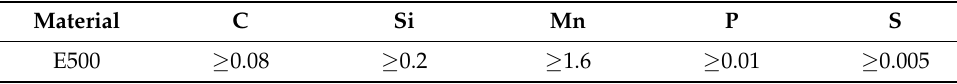
Table 1. Chemical composition of E500 steel (wt.%).